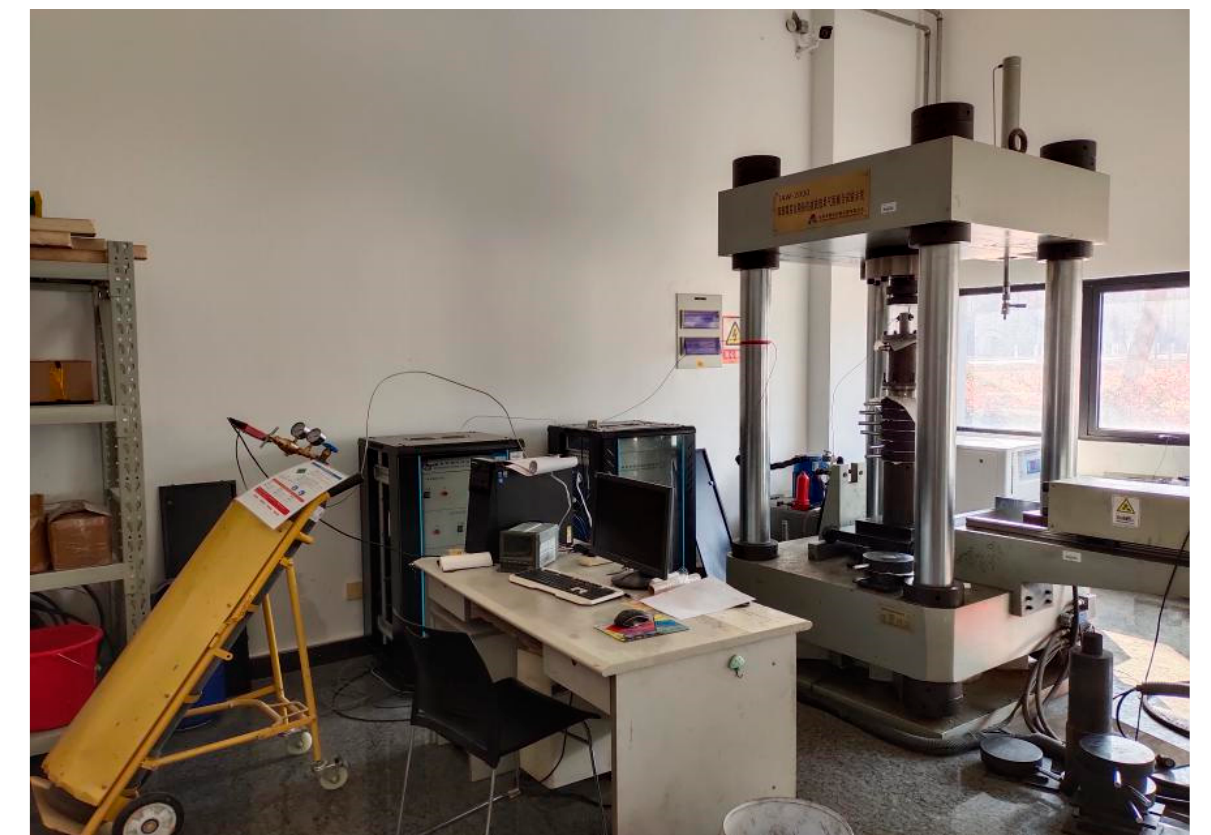
Figure 2. TAWD-2000 coal rock mechanics-seepage triaxial test system. Coal is a porous medium in which the seepage characteristics of gas depend on the number, size, and connectivity of pores and the pressure at both ends of pores in the flow direction. Hence, the permeability characteristics of the sample can be reflected by the relation curve between permeability and other related physical quantities. The principle of the coal permeability measurement test is shown in Figure 3. According to the principle, the steady-state method was adopted in the permeability test: First, different gas pressures were applied to the two ends of a coal sample with a constant pressure difference, so that a certain pressure gradient was formed in the coal sample to promote the flow of gas through the fractures. Meanwhile, the gas flow was measured. When the flow within the coal sample developed into a steady-state flow, the amount of gas flowing through the sample over a while was recorded. The recorded amount can be substituted into the governing Equation (1) to calculate the permeability of the coal sample [19].